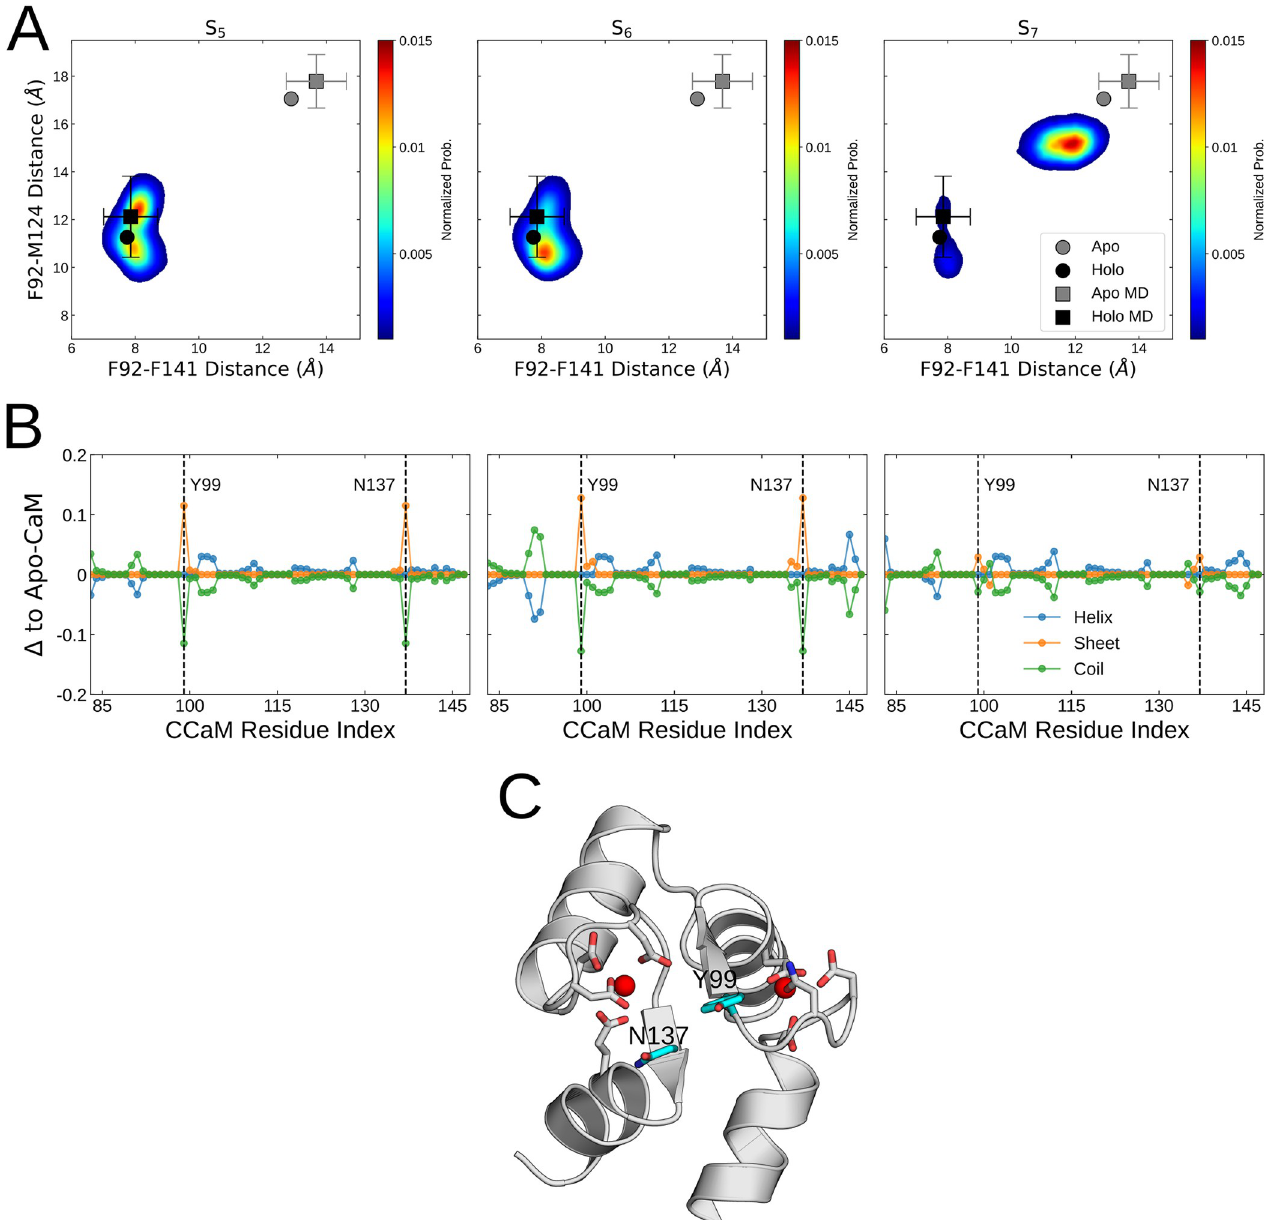
Fig 5. (A) Inter-residue distances between the sidechains of the F92, M124 and F141 within the S 5 , S 6 and S 7 macrostates. The two-dimensional histograms are weighted by their Markov state model probabilities. The inter-residue distances calculated from apo- (PDB: 1CFD [9]) and holo- (PDB: 1CLL [8]) calmodulin structures are shown as grey and black dots respectively. The mean inter-residue distances within MD simulations [5] of apo- and holo- CaM are shown as grey and black squares respectively. Error bars represent the standard deviations of residue distances within the MD simulations. (B) The per-residue secondary structure of C-CaM within the three populated macrostates compared to their behaviour within simulations of apo- CaM. The Y99 and N137 residues displaying enhanced sheet behaviour are illustrated as dotted lines. (C) The molecular structure of C-CaM illustrating the Y99-N137 antiparallel sheet situated adjacent to the two Ca 2+ ion binding sites. The bound Ca 2+ ions are shown as red